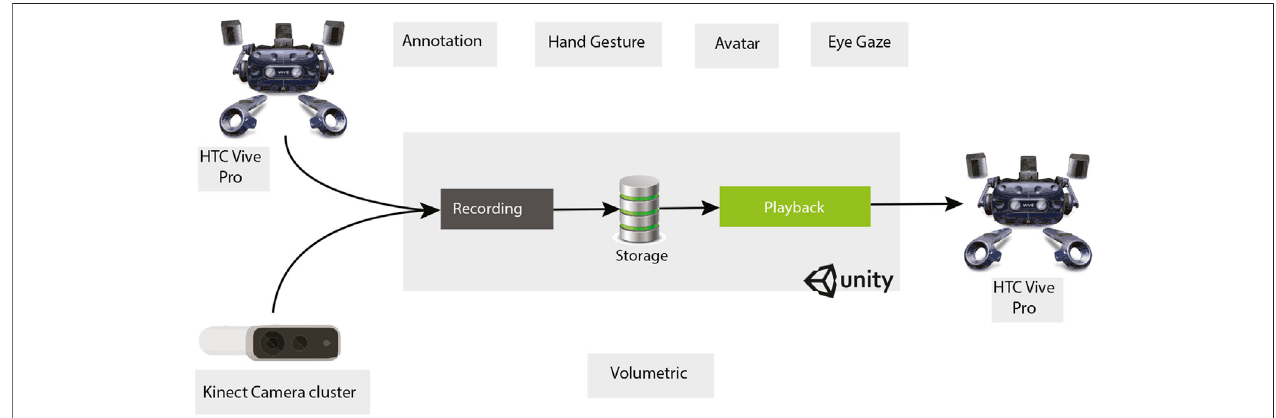
FIGURE 1 | The overview of our MR training system. Volumetric Capture is facilitated by Kinect Camera cluster and all other visual cues are captured and played back using HTC Vive.